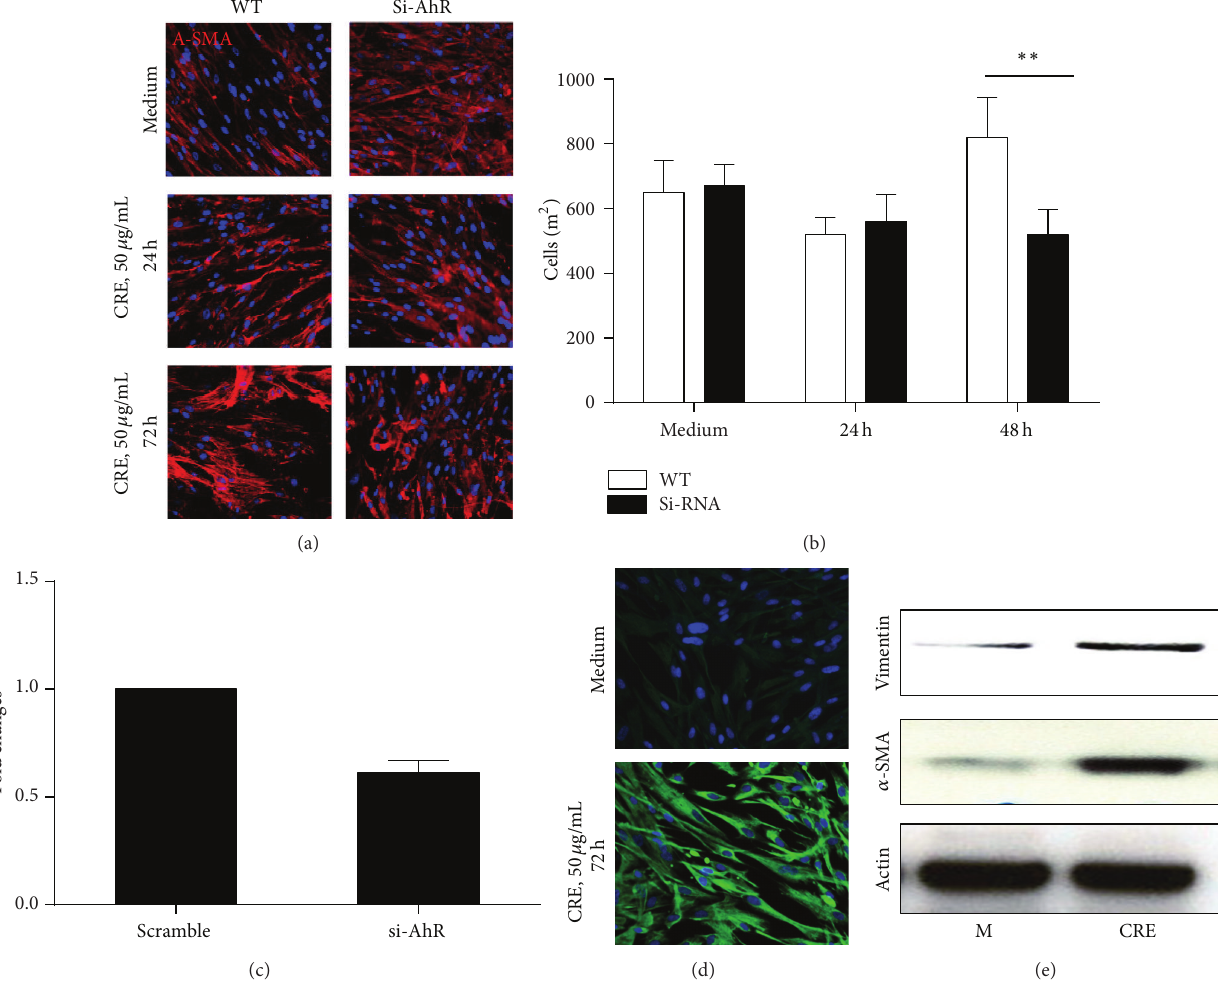
Figure 5: AhR controls fibroblast differentiation induced by CRE. (a) Differentiation of fibroblasts with and without AhR knockdown was evaluated by the expression of 𝛼 -SMA with DAPI for nuclei immune-staining after cells were treated with CRE (50 𝜇 g/mL) for 24 and 72 hours. (b) Positive staining for 𝛼 -SMA was analyzed by Imaging software (iVision; Biovision). (c) 𝛼 -SMA expression was detected by RT- PCR in fibroblasts with or without AhR knockdown. Bars represent mean ± SEM of 3 independent experiments, ∗∗ 𝑃 < 0.01 . (d) Vimentin was detected by immune-staining after cells were treated with CRE (50 𝜇 g/mL) for 72 hours. (e) Both 𝛼 -SMA and vimentin expression were detected by western blots after WI38 cells were treated with 50 𝜇 g/mL CRE for 72